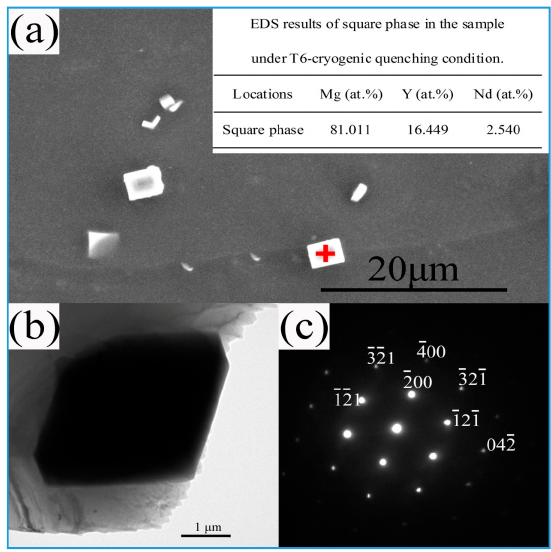
Figure 6. ( a ) Amplifying SEM image, EDS results; ( b ) TEM (transmission electron microscopy) image; and ( c ) SEAD pattern of the square phase after T6-cryogenic quenching.